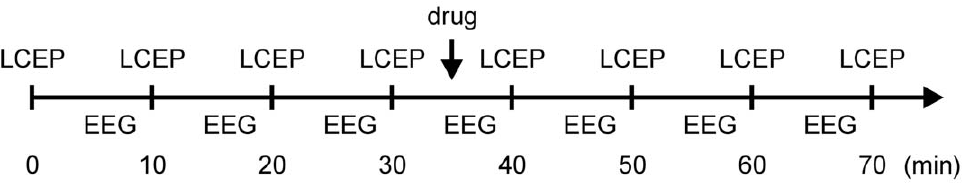
Figure 2. An overview of the stimulation protocol. LCEP stimulation was performed every 10 minutes. The first LCEP (t=0) and the first LCEP after drug were not included in the data analysis (see methods). ‘‘EEG’’ mark the time period during which 2 separate EEG recordings were